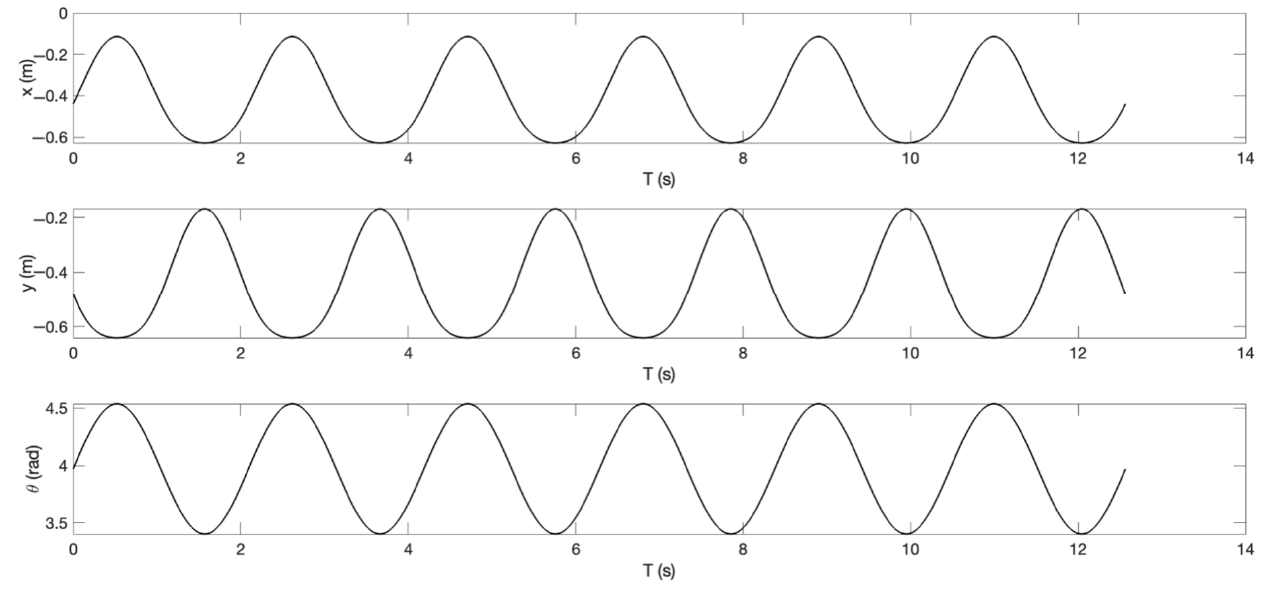
Figure 17. The Cartesian reference trajectory for the footrest motion projected on the x-axis and y-axis.